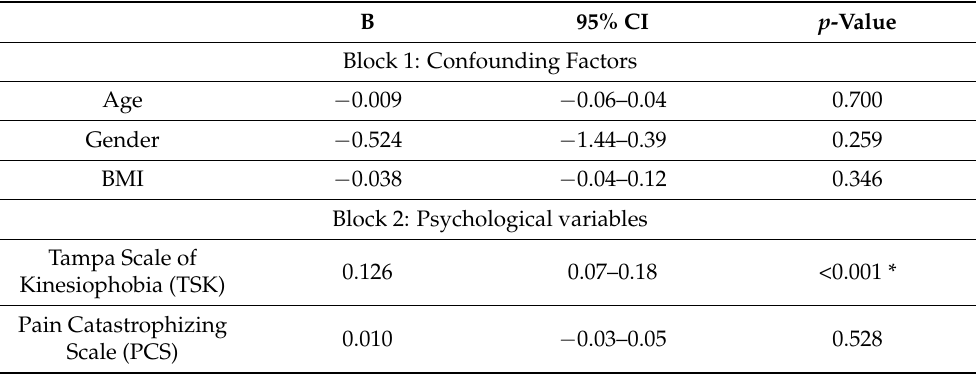
Table 2. Multivariable linear regression model examining the independent effect of demographic features and psychological components of kinesiophobia (TSK score) and pain catastrophizing (PCS score) on pain intensity (NPRS